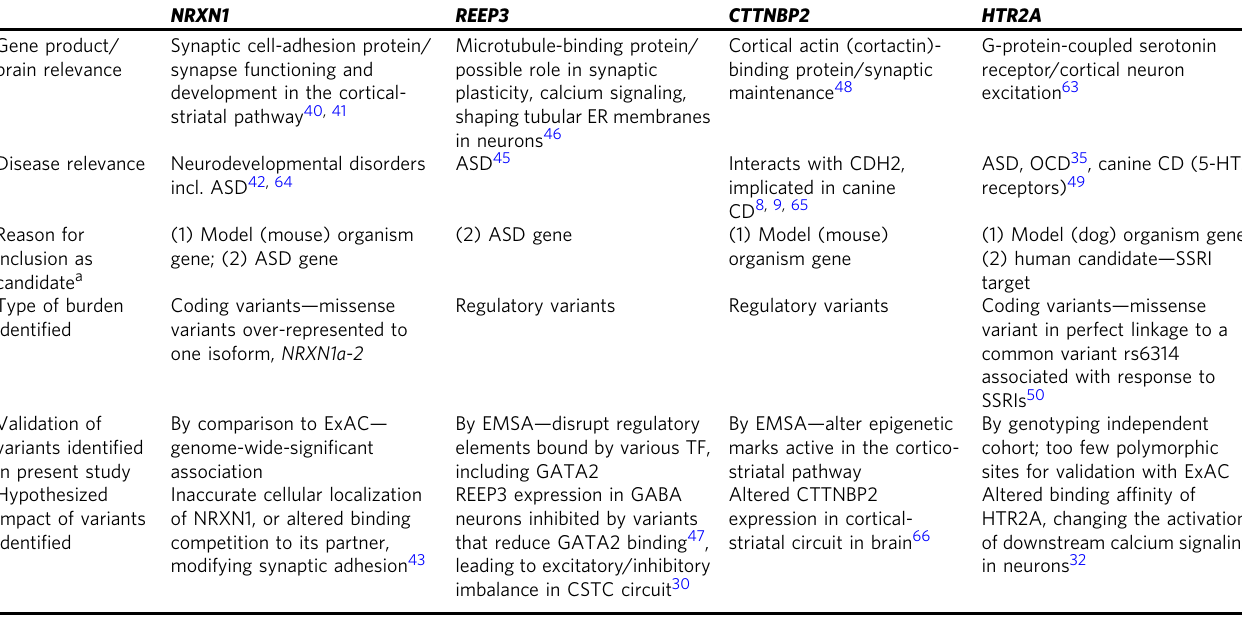
Table 4 Summary of top